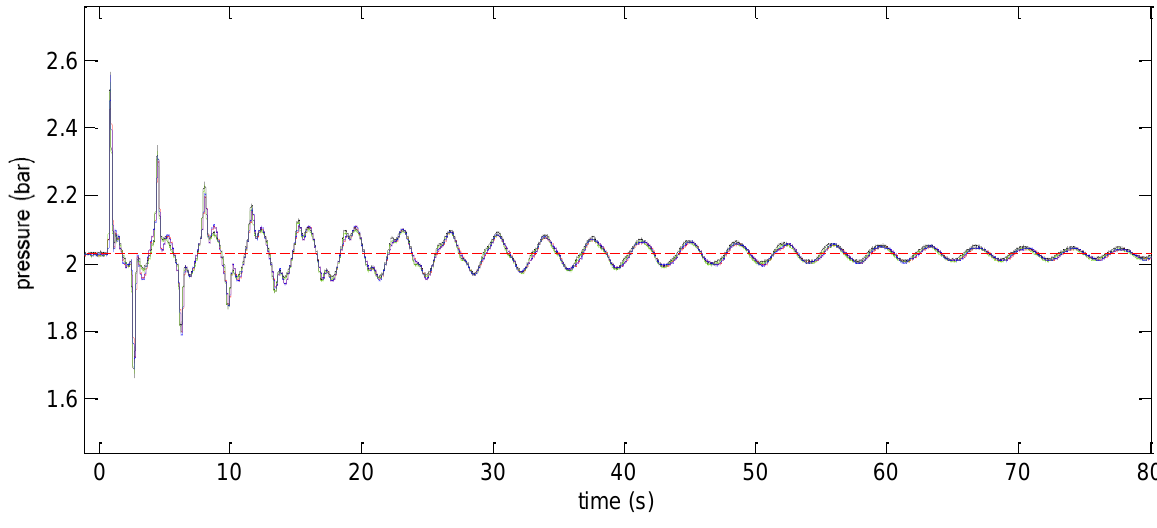
located at point 1 for four repeated 1